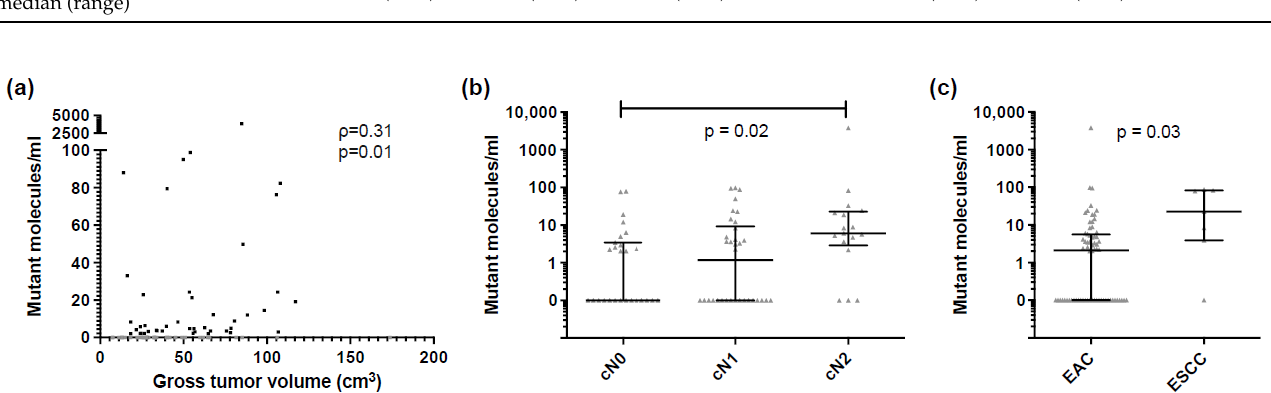
Figure 2. ctDNA levels pre-CRT (T0) and association with clinicopathological characteristics ( a ) Comparison of number of mutant molecules per ml plasma with gross tumor volume in cm 3 . Gross tumor volume of ctDNA negative samples is displayed in grey. Correlation was assessed using Spearman rank correlation coefficient. Comparison of number of mutant molecules per ml plasma with ( b ) suspected lymph node status and ( c ) pathological tumor subtype. Median and interquartile range are shown. p -values were calculated using Kruskal – Wallis test and Mann – Whitney test. Esophageal adenocarcinoma (EAC), esophageal squamous cell carcinoma (ESCC) . 3.3. Preoperative ctDNA Detection Was Associated with Higher Risk of Recurrence